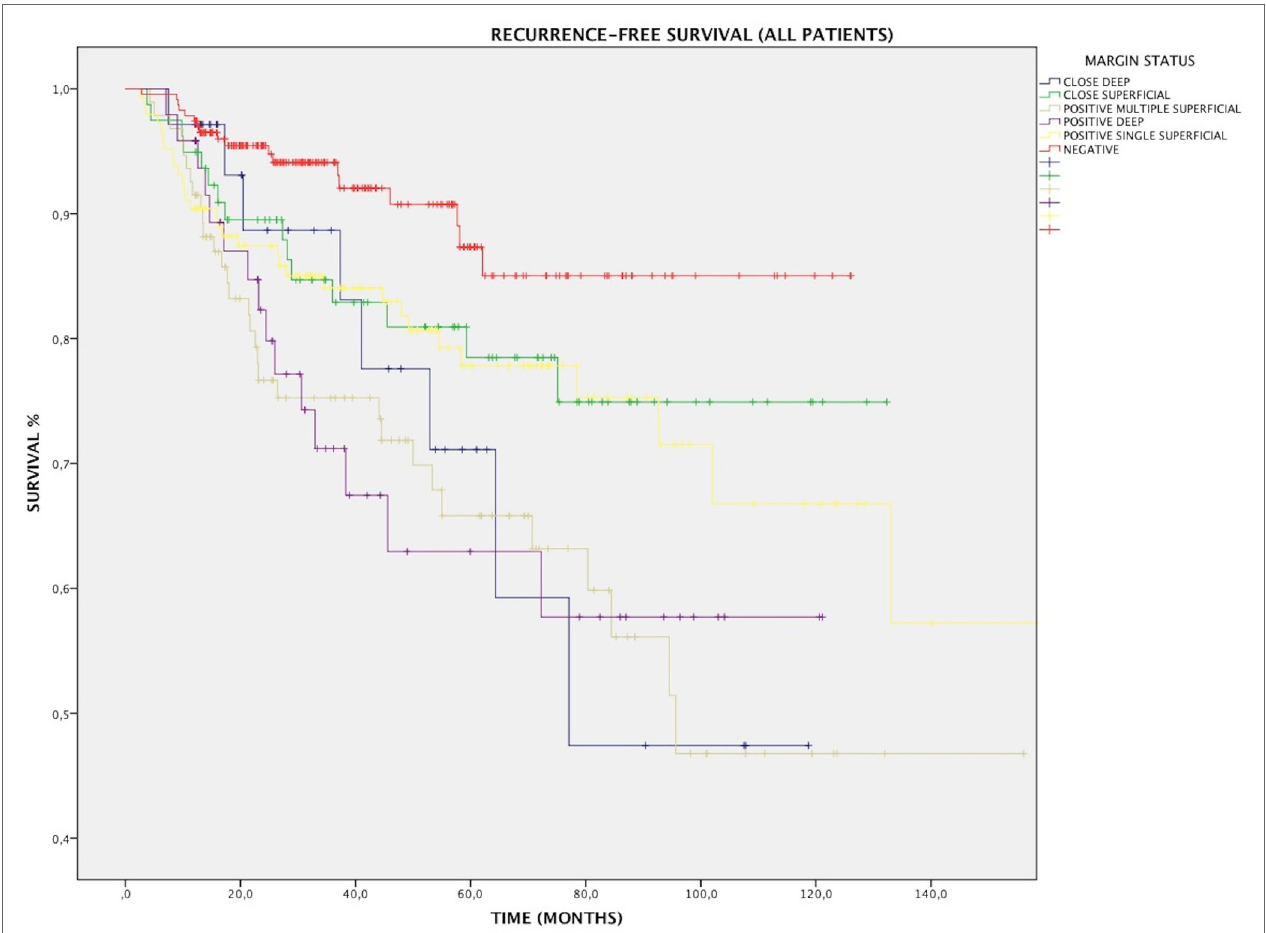
FigUre 3 | Kaplan–Meier curves for the entire patients cohort showing recurrence-free survival in relation to margin status. MS, positive multiple superficial margins; SS, positive single superficial margin; “ + ” symbol, censored